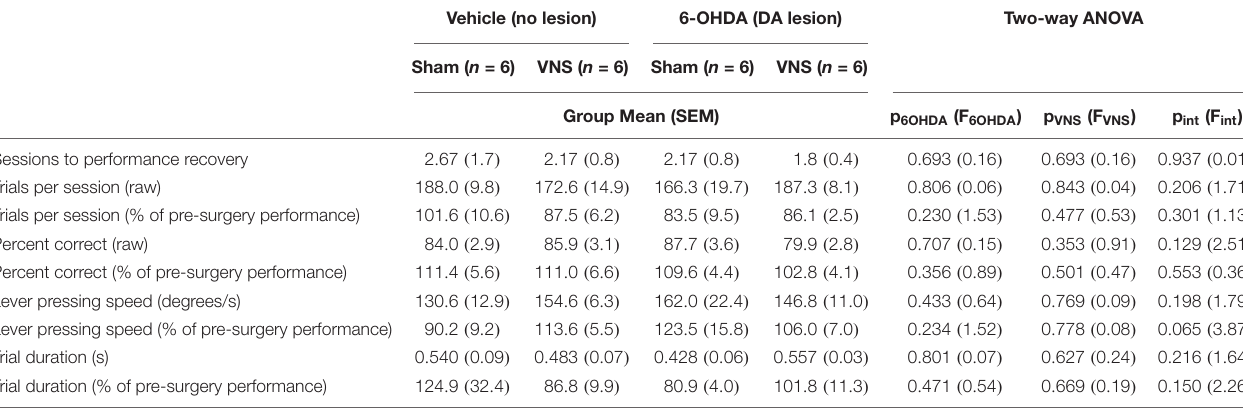
TABLE 2 | Behavioral performance during the recovery (pre-stimulation) period did not differ across treatment